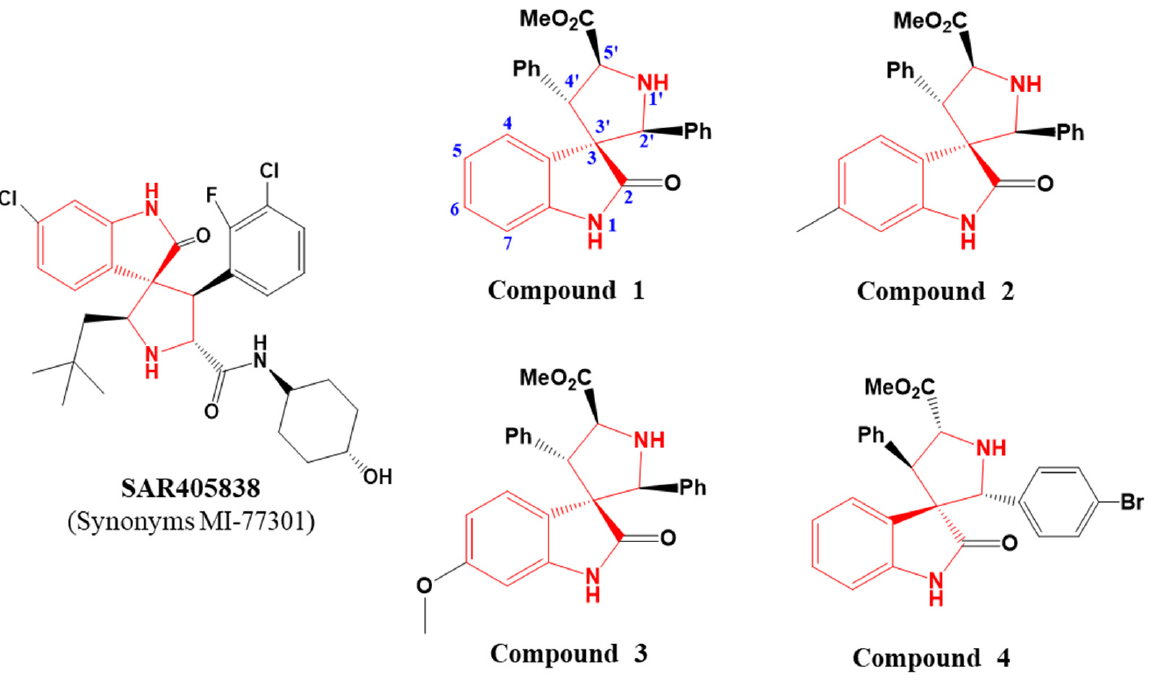
Figure 1. Chemical structures of a series of spiro-oxindole skeleton compounds and an inhibitor targeting MDM2 protein named SAR405838.